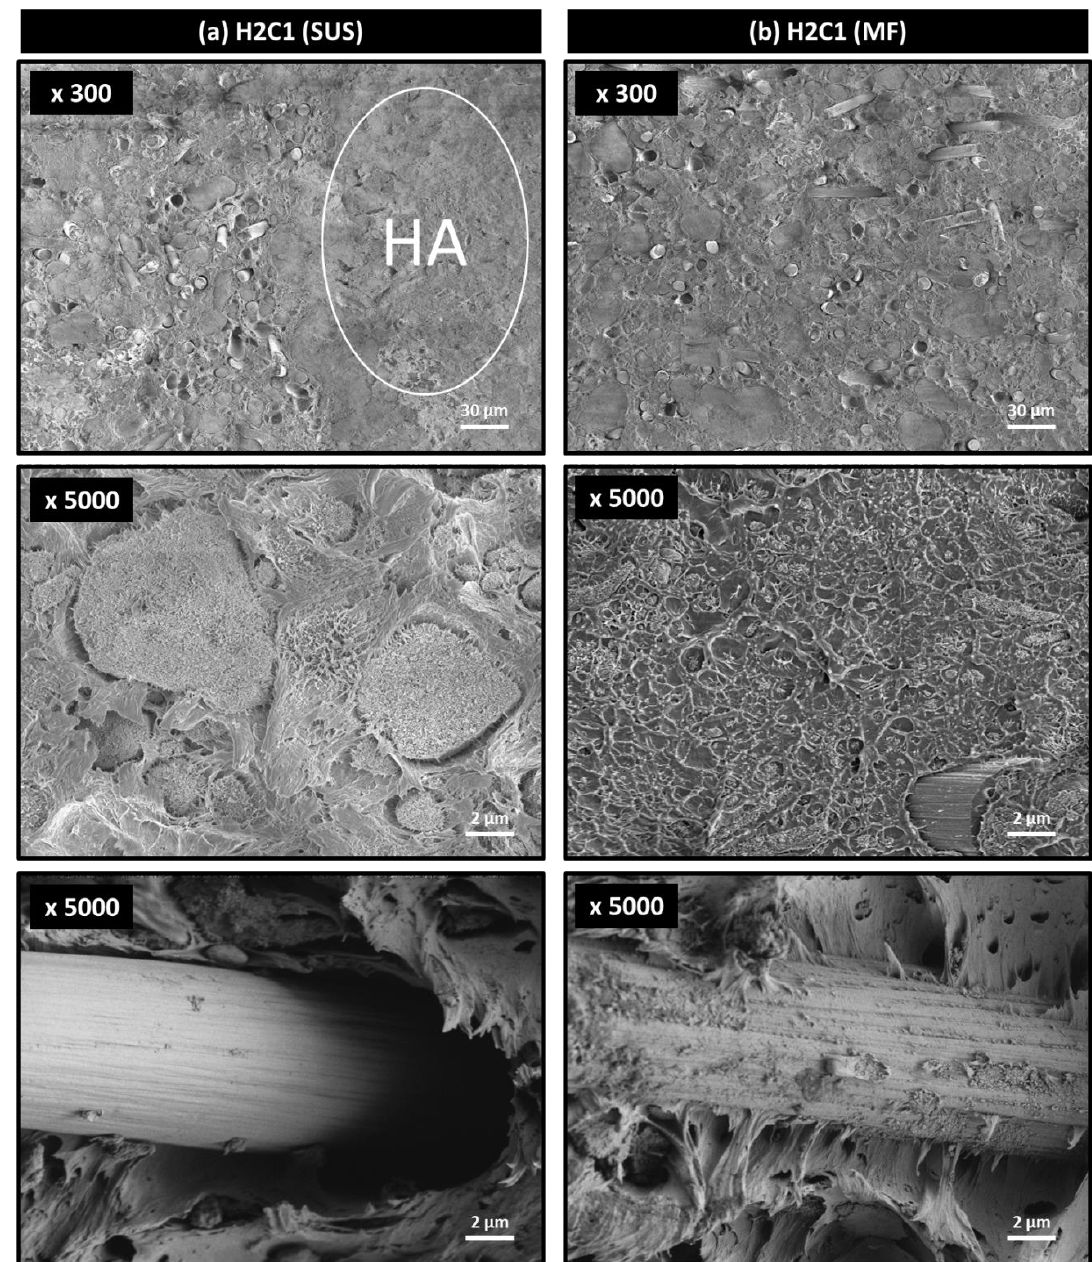
Figure 4. Fracture morphologies of H2C1 composites made by ( a ) SUS and ( b ) MF methods .